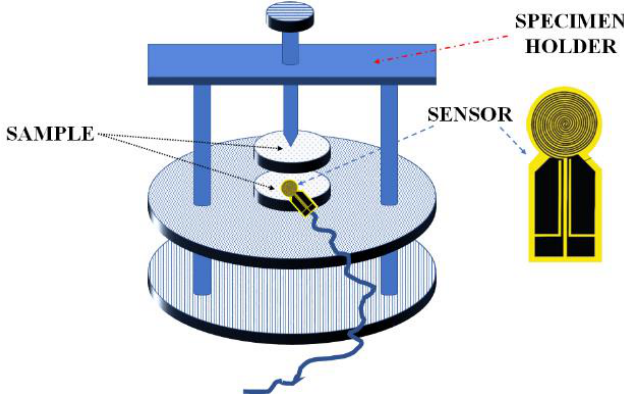
Figure 14. Double-spiral sensor for the TPS method, redrawn considering [115]. The sensor is heated by an electric current flowing through it, and, consequently, its electrical resistance increases with temperature dependent on time. If the tested material is opaque under thermal radiation, the heat generated by the sensor is exclusively delivered to the sample by conduction. Then, the temperature increase in the sensor, ∆ T , can be split up into two parts: where ∆ T i is the temperature difference across the sensor insulation layer, which combines the effects of the thermal contact resistance and the adhesive between the heat element and the insulation layer of the sensor, and τ is the dimensionless time (Fourier number) defined √ α t / r 2 , with α representing the thermal diffusivity of the sample, and r the radius of as τ = the outermost ring of the sensor. ∆ T ( τ ) is the temperature rise in the sensor outer surface. In particular, when its double-spiral configuration is approximated by equally spaced concentric circular line sources, the term ∆ T ( τ ) is described by the following equation